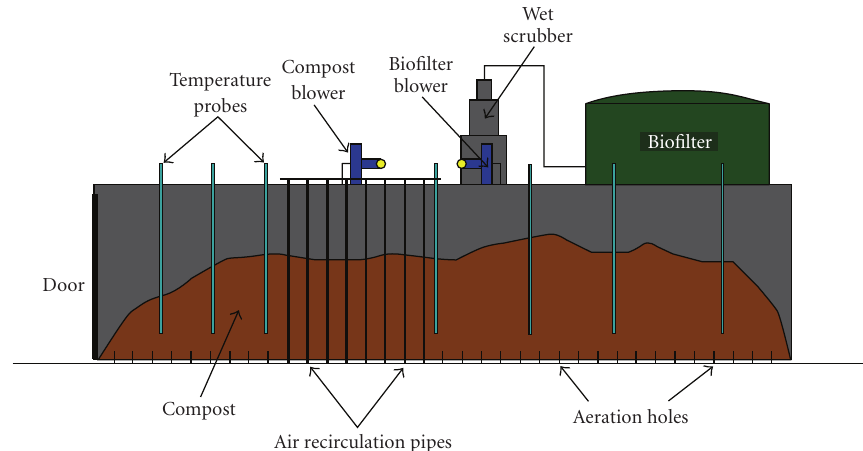
Figure 2: In-vessel unit cross-section.